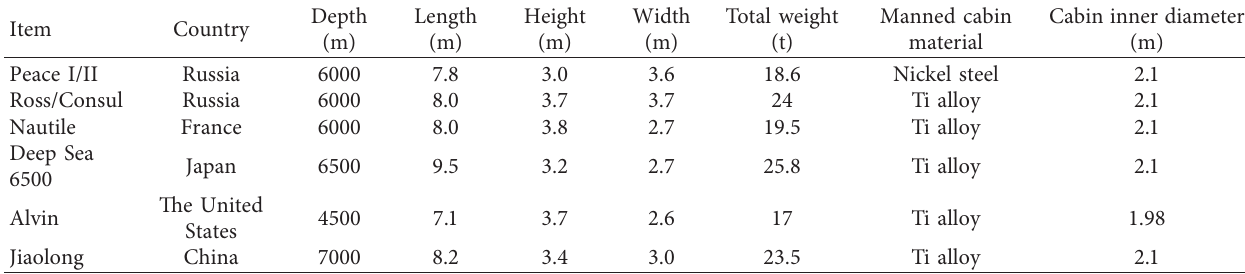
Table 1: Main technical parameters of domestic and foreign manned